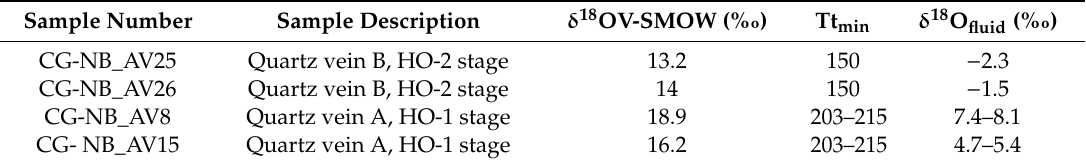
Table 2. Oxygen isotope data of vein quartz associated with hypogene iron ore in the Nabeba deposit.